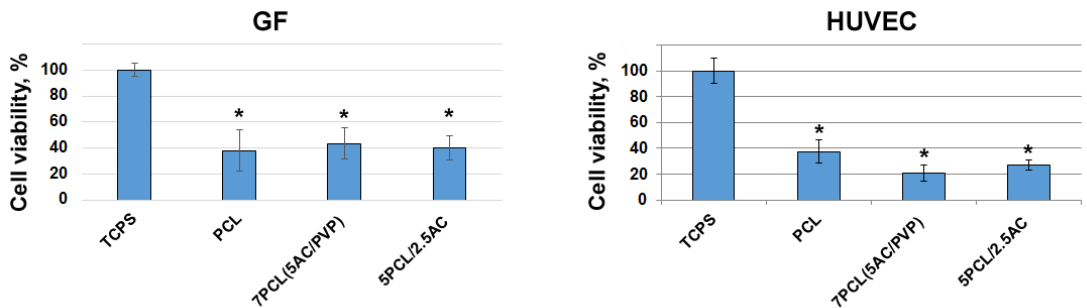
Figure 7. Viability of GFs and HUVECs cultured on scaffolds 48 h after seeding. Cell viability on scaffolds is represented as % to cells on TCPS. Data are shown as mean ± SD. * indicates statistically significant difference compared to TCPS ( p < 0.05).